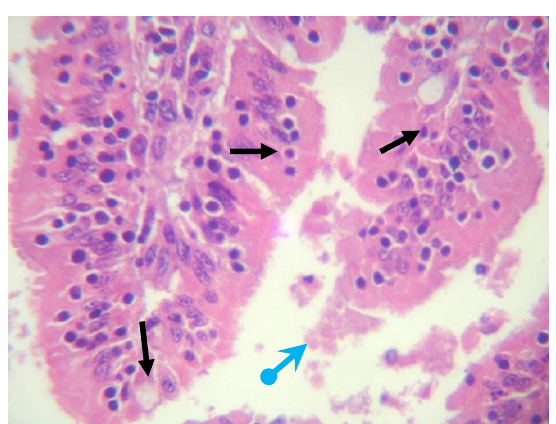
Fig 12: Microscopic section of intestine from 1st immunized group at 3 days post challenge show slight hypertrophy of goblet cells and slight sloughing of epithelium mucosal layer (H&E X20).